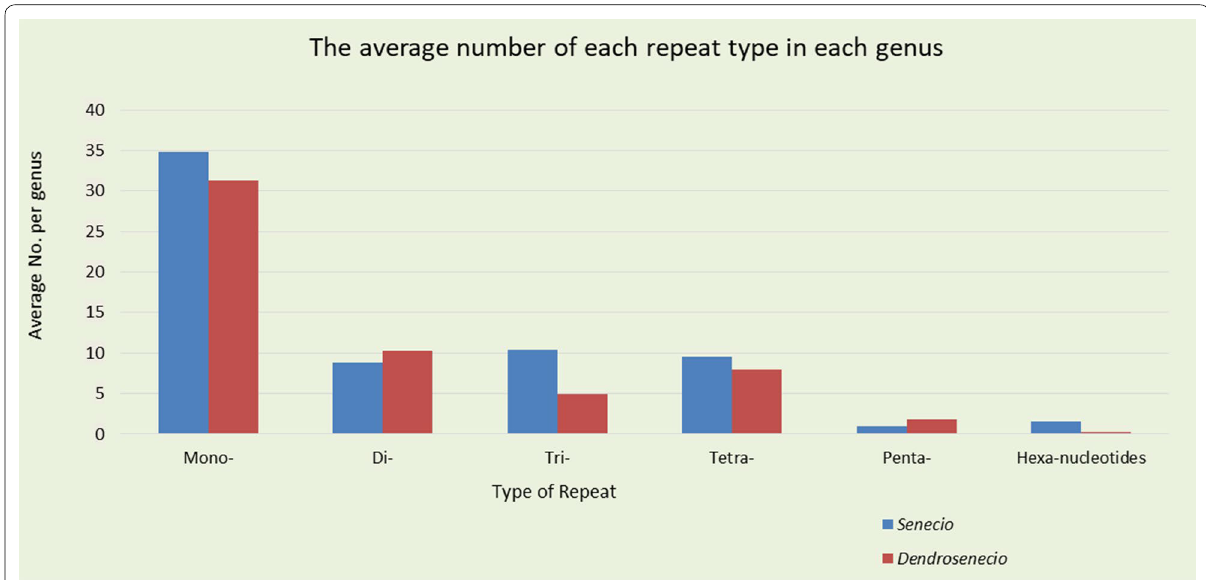
Fig. 3 The average number of each type of microsatellites in the chloroplast genomes of Dendrosenecio and